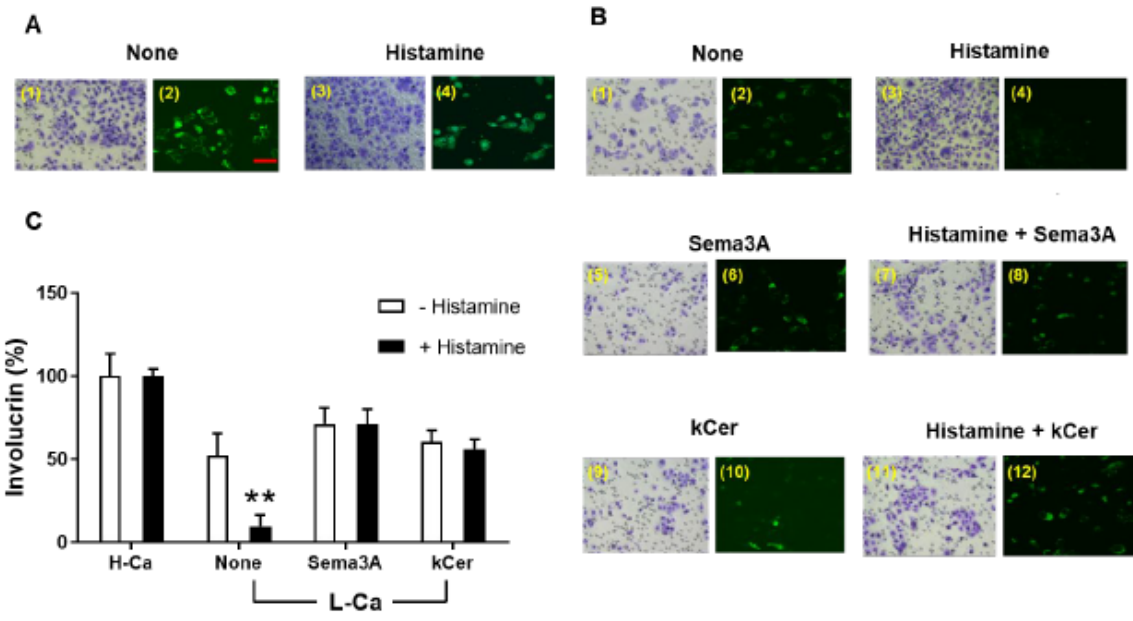
Figure 2. kCer-induced HaCaT cell differentiation and migration. Short-term cell culture was used for the HaCaT cell migration assay. Cell migration activity was determined quantitatively using ImageJ after GIEMSA’S AZUR EOSIN Methylene Blue-staining of the transwell filter membrane (left images in ( A , B )). Cells that migrated to the opposite side of the transwell membrane were immunostained with anti-involucrin antibody (right image in ( A , B )). ( C ) The differentiation effect of Sema3A (100 nM) and kCer (25 µ M) on HaCaT cells after short-term culture was compared in the presence or absence of 10 µ M histamine and quantified using Image J. Data are presented as means ± SD ( n = 3, ** p < 0.01). Scale bar = 100 μ m.